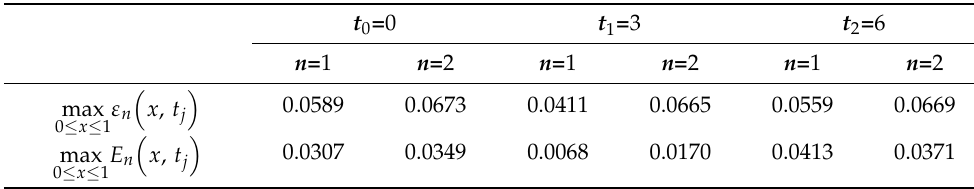
Table 1. Comparison of residuals for ϕ j .